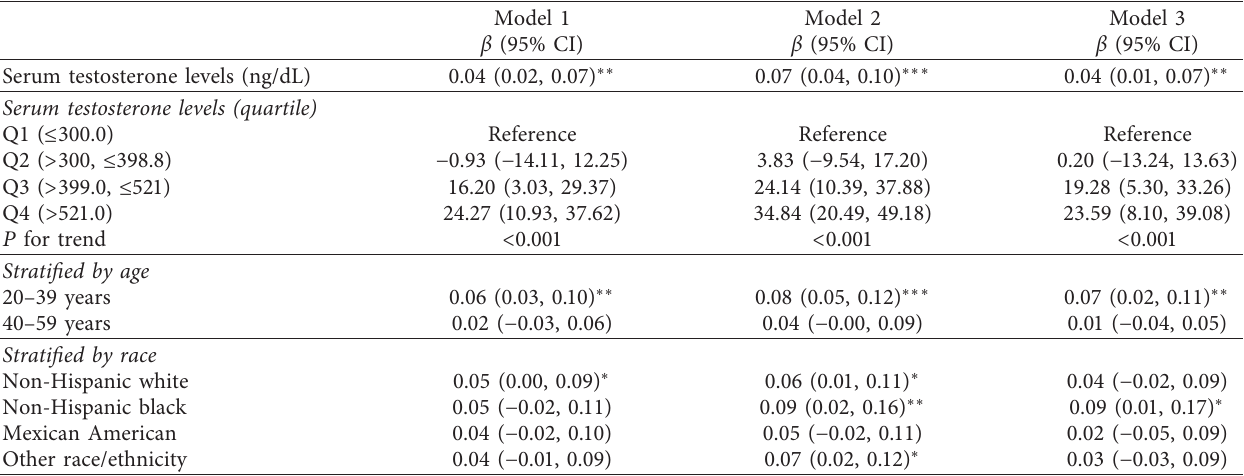
Table 2: Association between serum testosterone levels (ng/dL) and lumbar bone mineral density (mg/cm 2 ).